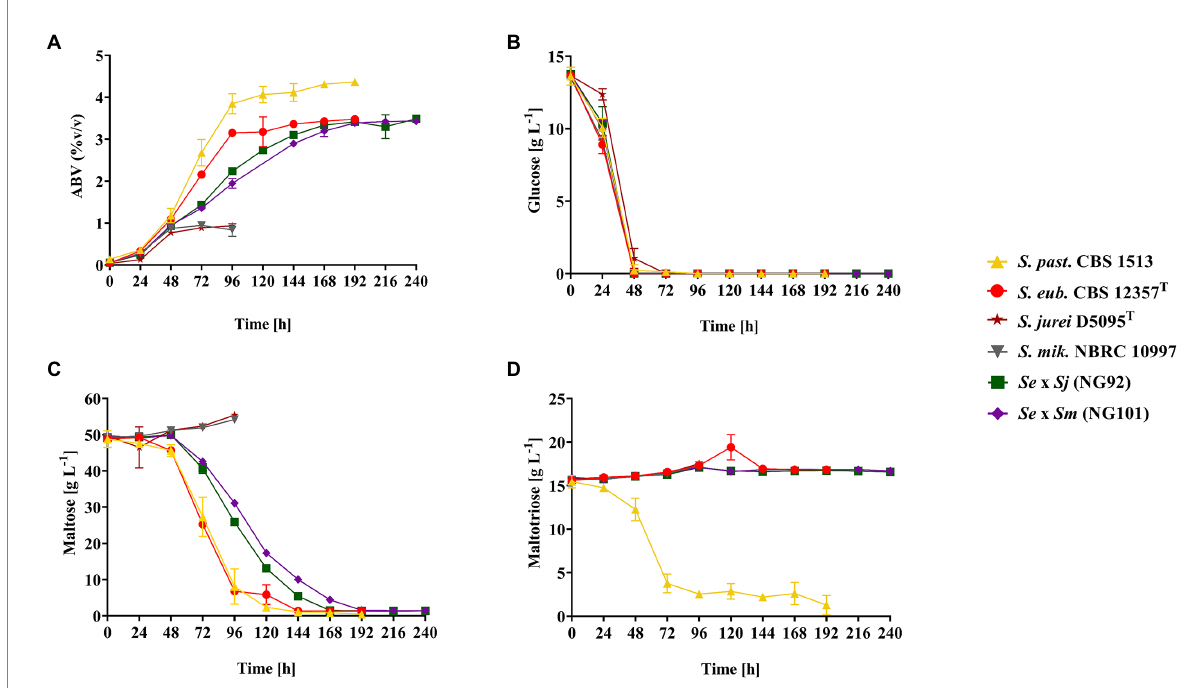
FIGURE 3 Fermentation in oxygen-limited conditions monitored by ethanol formation represented as alcohol by volume (ABV) [%] at 12 ° C for 10 days of fermentation of 12 o P wort. The strains tested include the maltotriose-positive (Mtt + ) strain S. pastorianus CBS 1513 ( ▲ ) as lager reference, the parental strains – S. eubayanus CBS 12357 T [maltotriose-negative (Mtt − )] ( ● ), S. jurei D5095 T (Mtt + ; ★ ), S. mikatae NBRC 10997 (Mtt + ; ▼ ) and the constructed de novo hybrids - NG92 ( S. eubayanus CBS 12357 T × S. jurei D5095 T /Se × Sj ; ■ ) and NG101 ( S. eubayanus CBS 12357 T × S. mikatae NBRC 10997/ Se × Sm ; ♦ ). Reduced oxygen availability was achieved by using relatively high culture volumes (200 ml in 300 ml infusion bottles). The bottles were equipped with a screw cap and septum with a needle allowing the release of CO 2 with reduced shaking